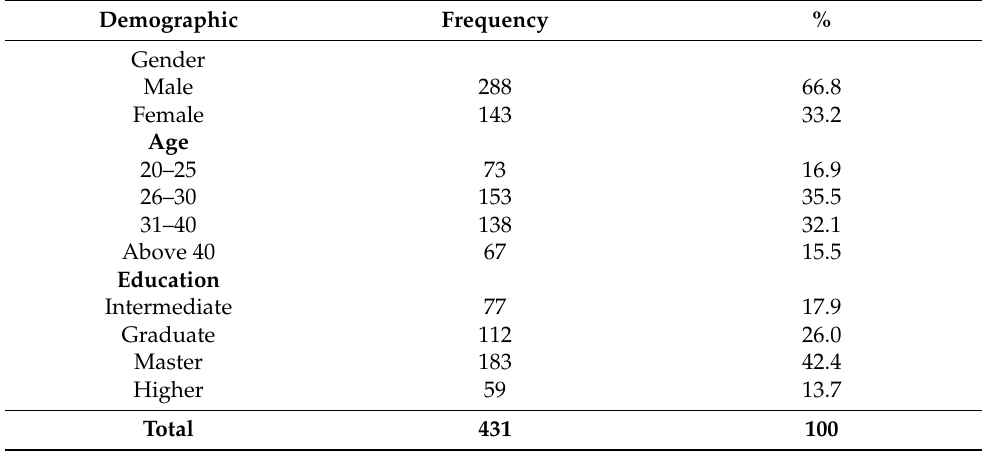
Table 1. Demographic information of the sample.